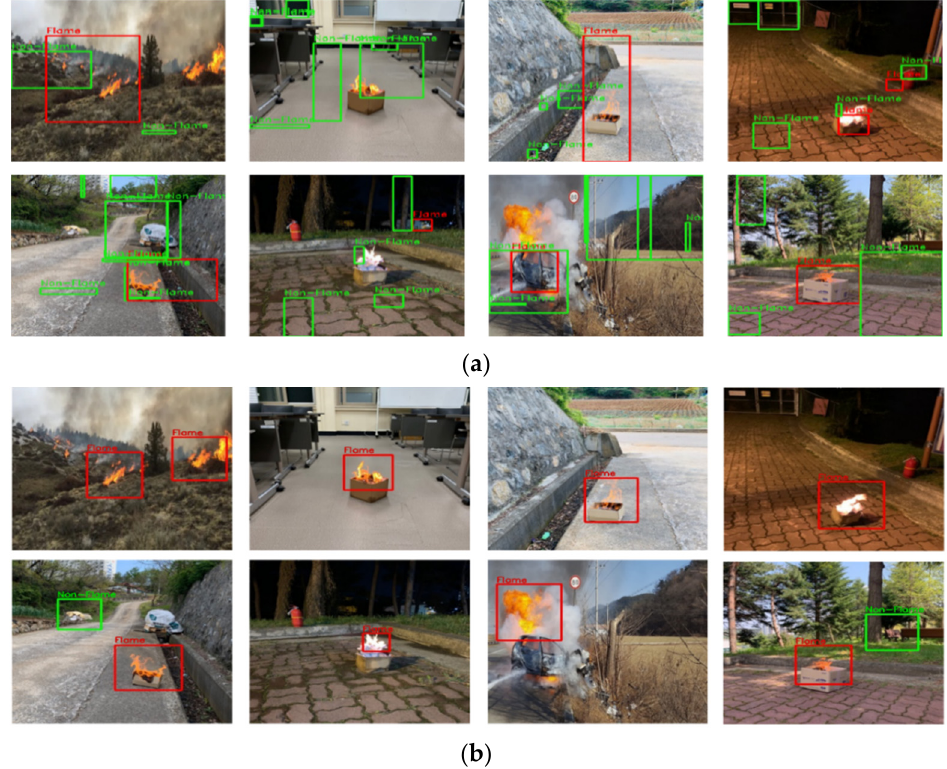
Figure 6. Flame detection results from the evaluation images. ( a ) CNN detection results for candidate regions using selective search of RGB images; ( b ) CNN detection results in candidate regions using proposed pre-processing method and selective search.